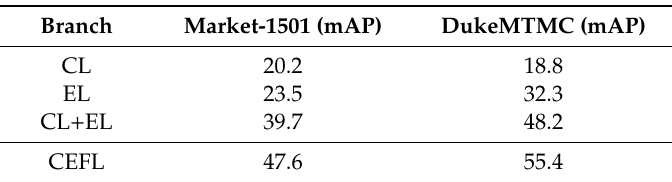
Table 3. Components analysis of